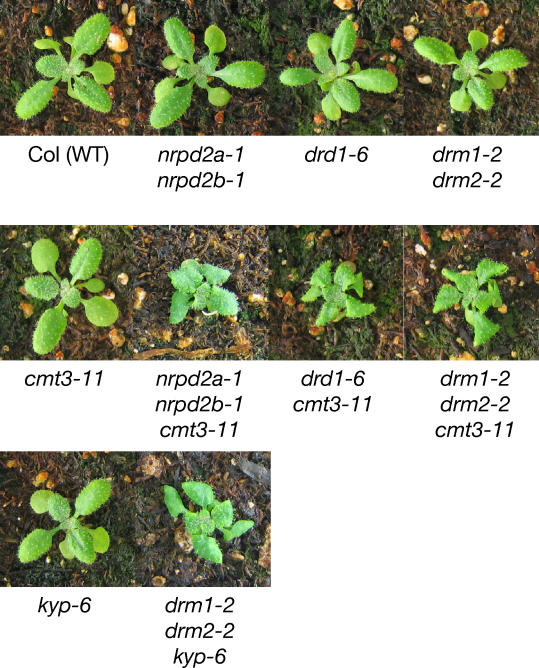
Developmentally Important Gene Regulation by DRM2 and CMT3 Requires RNAi, DRD1, and KRYPTONITERosette leaf shape defects in a variety of multiple mutant combinations are shown.Col (WT), wild-type Columbia ecotype.